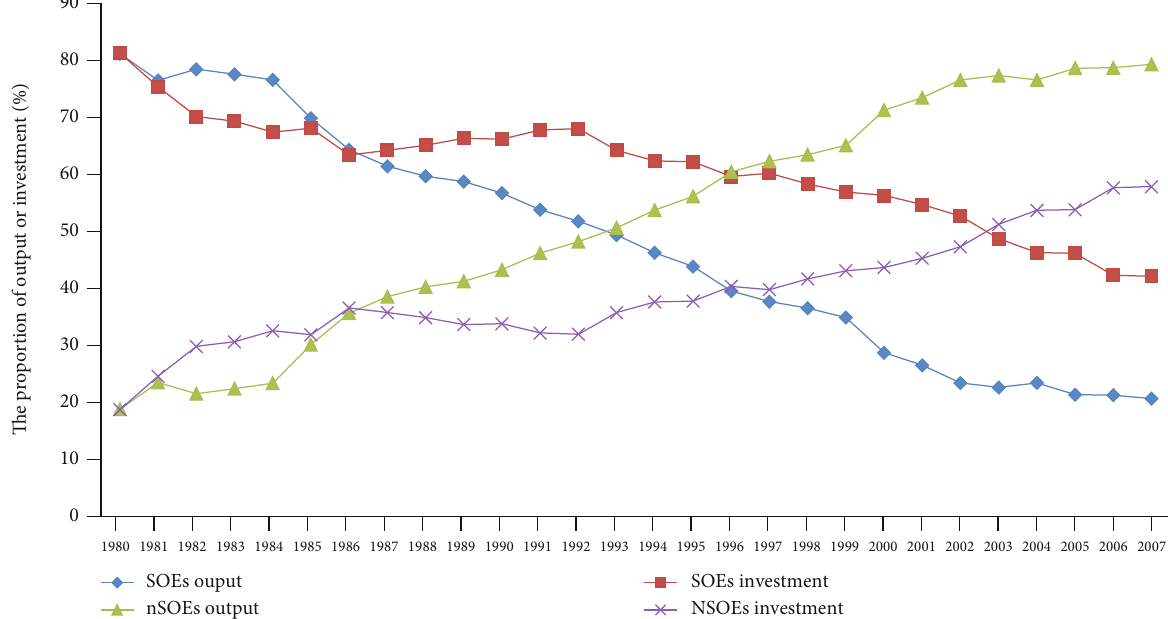
Figure 1: The proportion of output or investment of state-owned and non-state-owned enterprises. Data source: China Statistical Yearbook: 1981 –